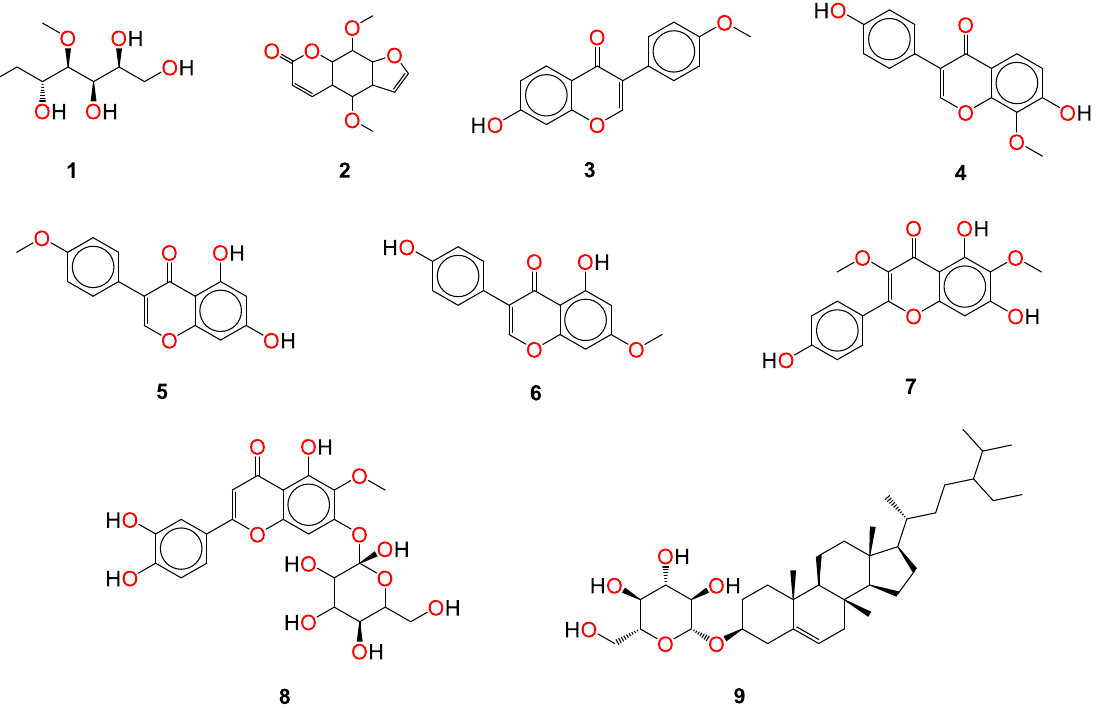
Figure 1. The isolated compounds from S. tomentosa L. leaves. 4- O -methyl sorbitol ( 1 ), 5,8-dimethoxypsoralen ( 2 ), formononetin ( 3 ), genistein 4’-methyl ether ( 4 ), 4’,5-dihydroxy-7-methoxygenistein ( 5 ), 8-methoxy daidzin ( 6 ), 5,7,4’-trihydroxy-3,6-dimethoxy flavone ( 7 ), 6-methoxy-7- O - β -D-glucoside apigenin ( 8 ), and daucosterol ( 9 ).